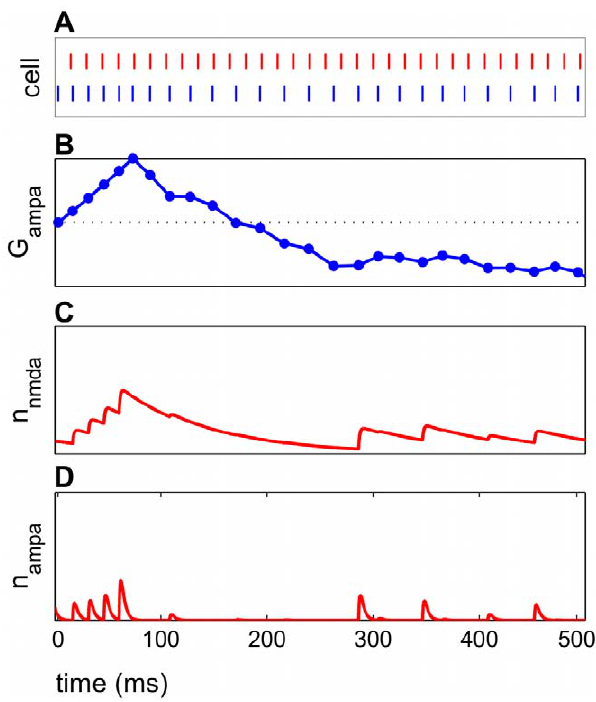
Figure 5. NMDAR currents exhibit a slower decay than AMPAR currents. A potentiating frequency regime is shown. (A) Raster plots for input spikes (red) and E cell spikes (blue) show positive spike pairs leading to potentiation. (B) AMPAR conductance over time shows potentiation and subsequent depression. (C) Open probability n nmda for I nmda has local maxima when an input spike immediately precedes an E cell spike, signaling a glutamatergic current. The NMDAR current has a long decay time constant and therefore a prolonged effect on the E cell spiking. (D) Open probability n ampa for I ampa has a faster rate of decay than NMDAR events.